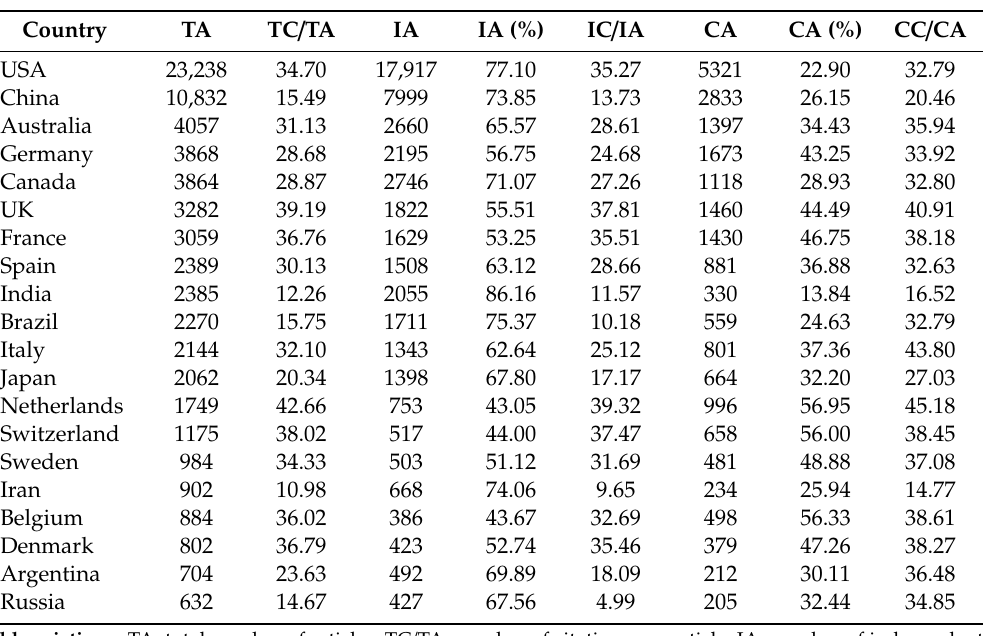
Table 4. Top 20 productive countries / territories in SW research.